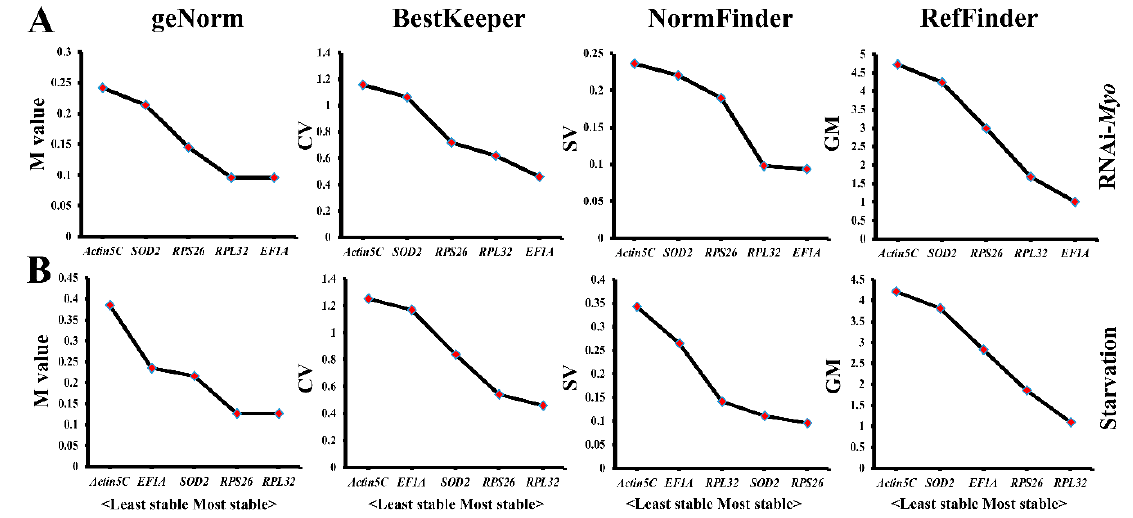
Figure 4. Stable analysis of five candidate genes under RNAi- Myo ( A ) or starvation stresses ( B ) based on four algorithms.